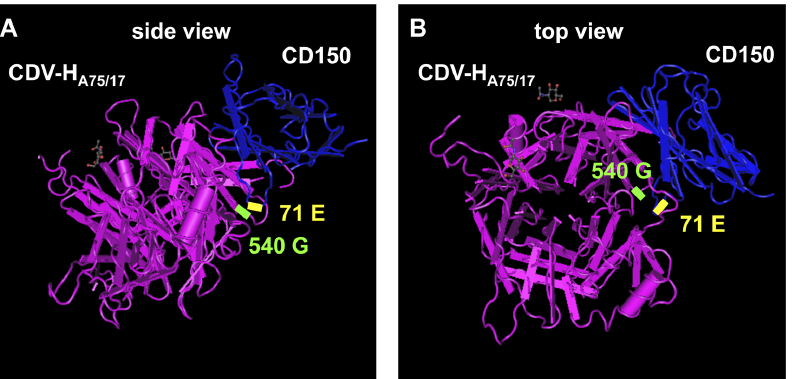
Figure 7. Structural model of the CDV-H-CD150 interaction. Side (A) and top (B) view of the globular head of CDV-H (amino acids 188 to 602) presented in magenta with highlighted amino acid 540 G (green), and of the interacting first V-like domain of human CD150 (amino acids 32 to 140) shown in blue with highlighted amino acid 71 E (yellow). The structures were modelled based on the crystal structure of MV-H bound to CD150 [33].